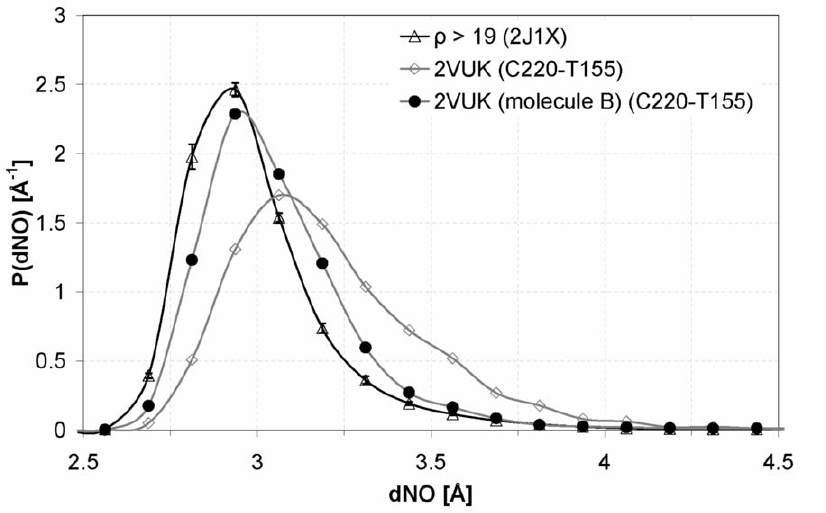
Figure 8. Distribution of the distance between the N atom of the amide group and the O atom of the carbonyl. HBs with r . 19 in 2J1X ( m =2.949 and s =0.276), CYS 220– THR 155 in 2VUK ( m =3.150 and s =0.288) and CYS 220– THR 155 in the second modification of Phikan083 (molecule B in Fig. 7; m =3.000 and s =0.235).